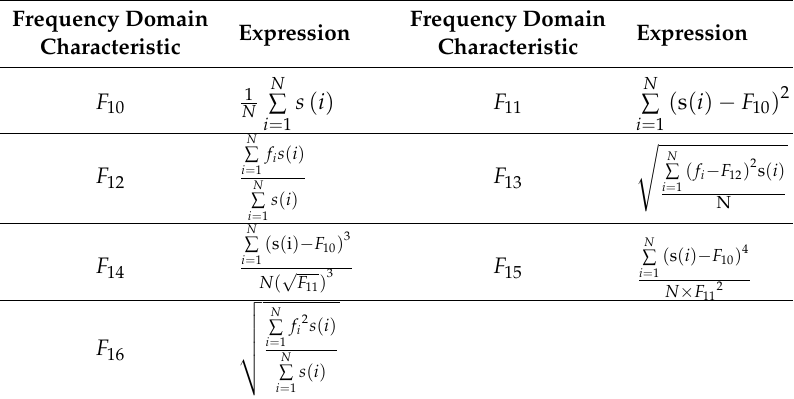
Table 3. Numerical explanation of frequency